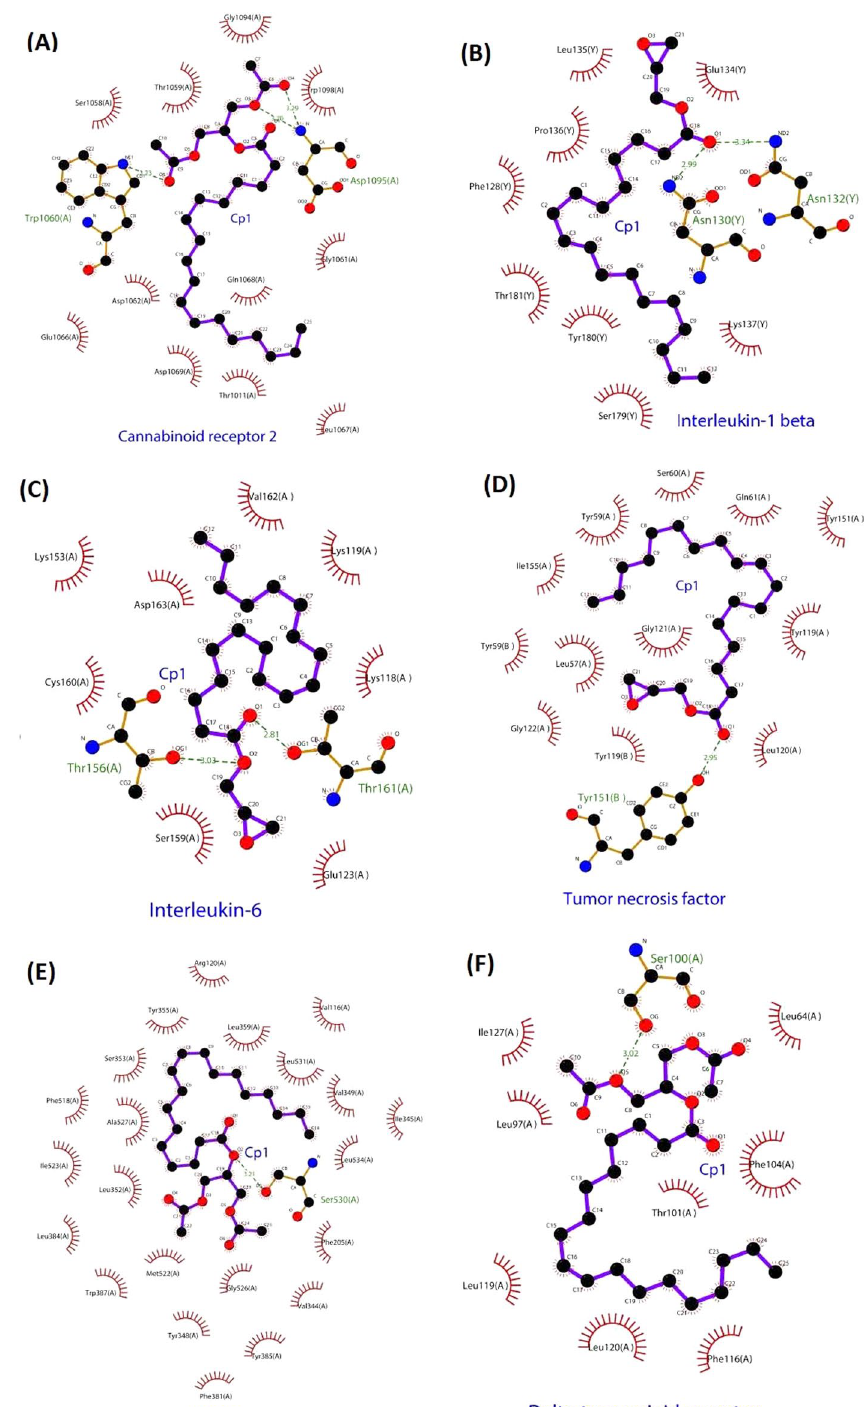
Fig. 10 2D interaction of the hydrogen bond in Glyceryl diacetate-2-Oleate (cp1) against six selected major target proteins of Ruellia . A Cp1 and CB2; B Cp1 and IL-1 β ; C Cp1 and IL-6; D Cp1 and TNF; E Cp1 and PTGS1; F Cp1 and DOPR. The blue colour indicates hydrogen bond interactions with side chain amino acid (mild polar) and pink represents the hydrophobic